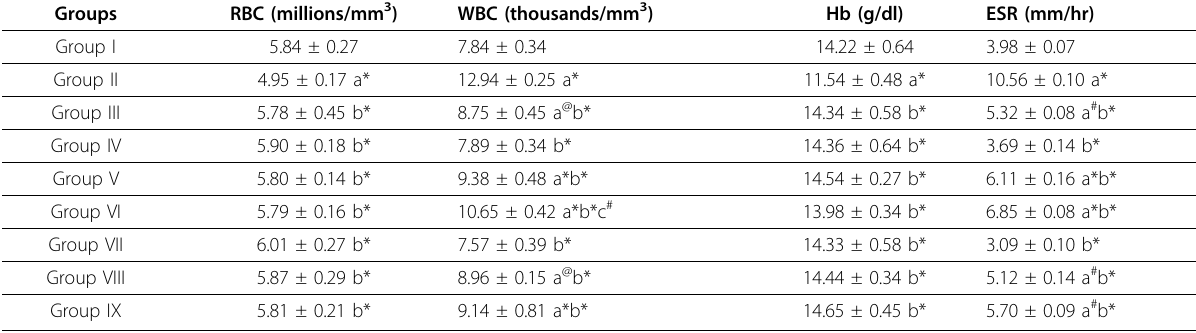
Table 2 Effects of SPP and SPE on haematological parameters of control and adjuvant induced arthritic rats